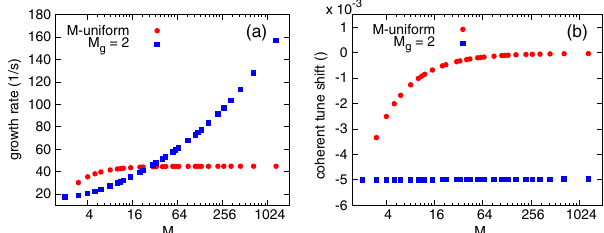
FIG. 4. Complex frequency shift with the largest imaginary part for all possible uniform filling patterns with M ≤ h , shown by the red dots, compared with the uniform filling pattern case with a gap g ¼ M − 2 , shown by the blue squares: growth rate (a); coherent tune shift (b). I 0 ¼ 12 . 7